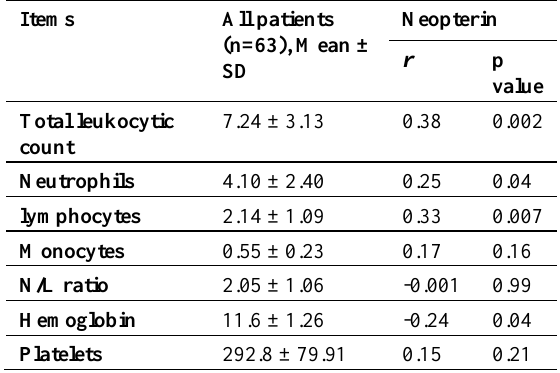
Table 2: Correlation between complete blood count measurements and neopterin level